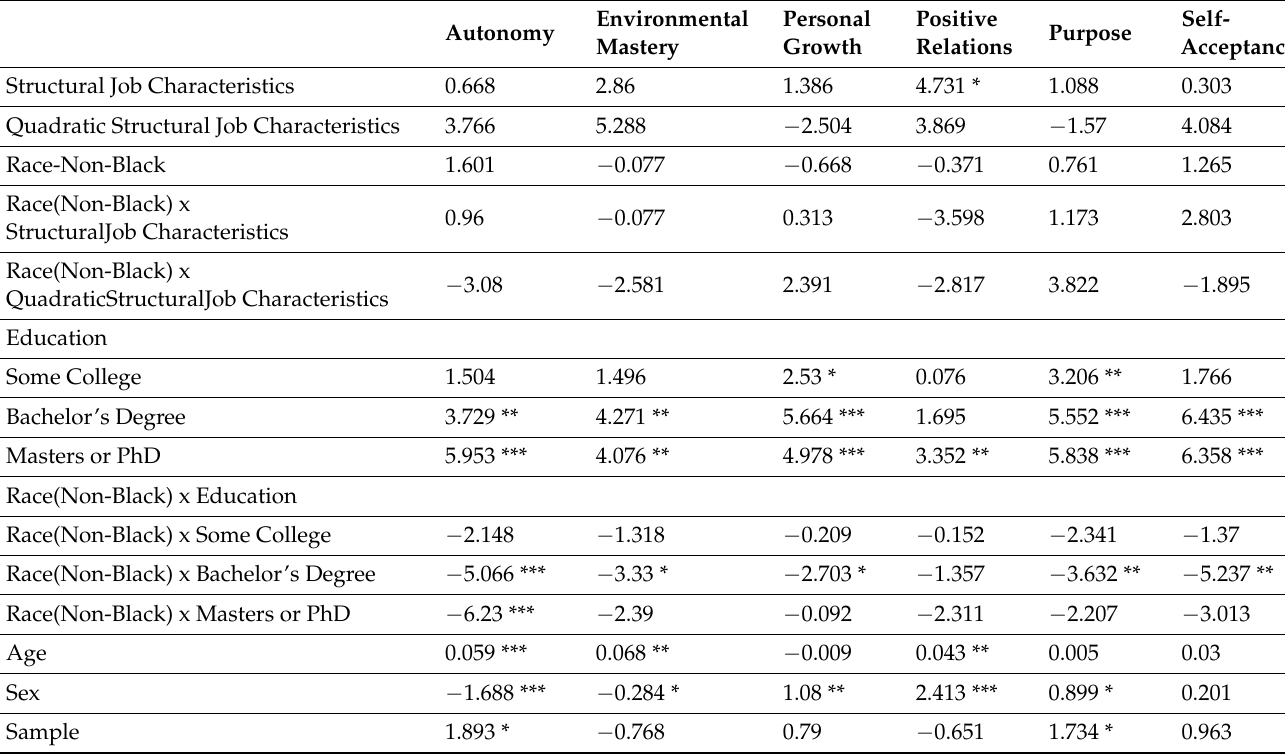
Table A9. Structural Job Characteristics and